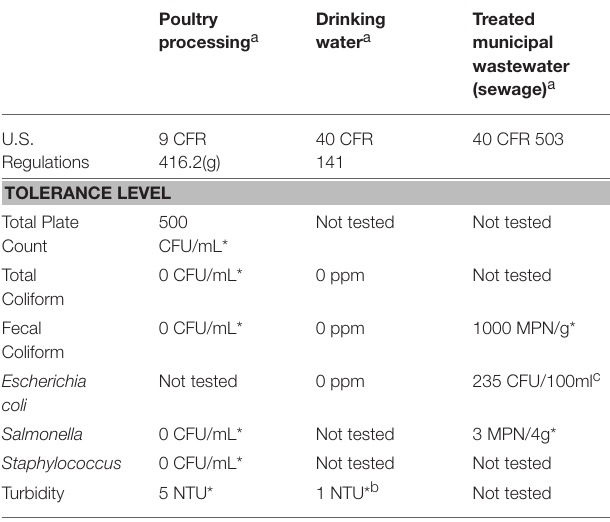
TABLE 1 | U.S. regulations of different waters and acceptable